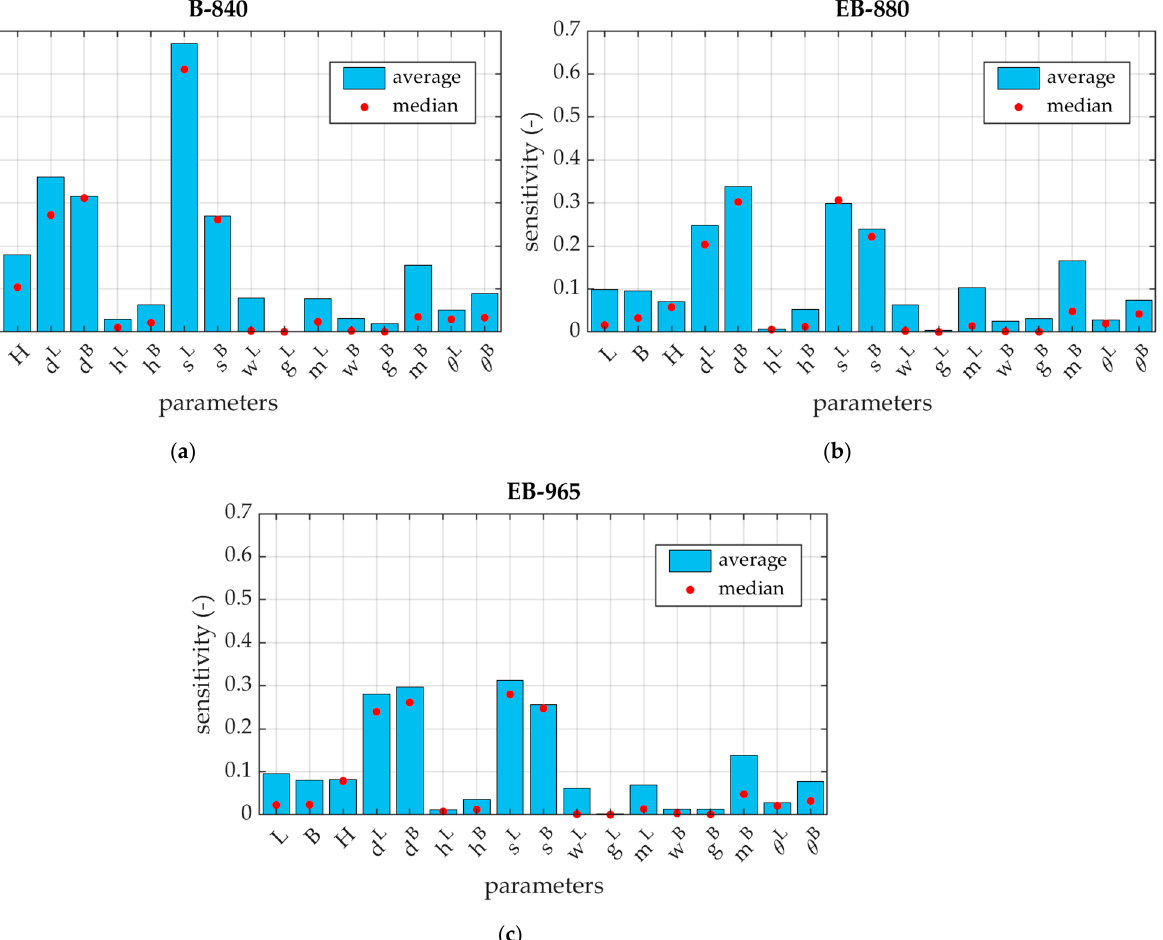
Figure 7. Average and median sensitivities for 17 analyzed parameters for three different cardboards: ( a ) B-840, ( b ) EB-880, and ( c ) EB-965.